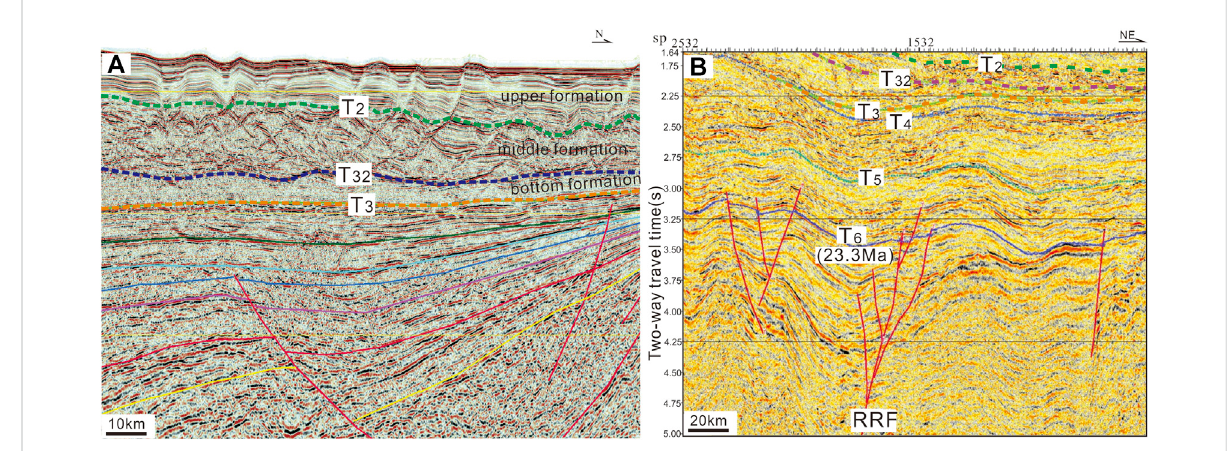
FIGURE 7 Seismic re fl ection sections of the Huaguang Sag of the Qiongdongnan Basin (A) and Yinggehai Basin (B) , cited by Liu et al, 2015a. Note: The locations of Sections a and b are shown Lines A7 and A8 in Figure 1, respectively.